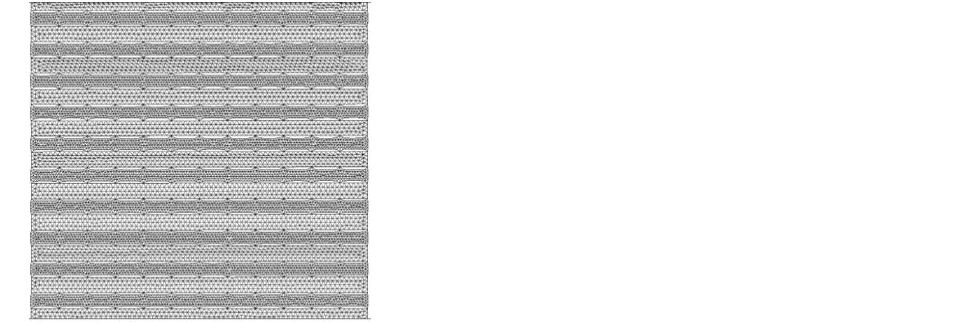
Figure 13. The computational domain with FEM mesh under tension across CF without any node discontinuities.